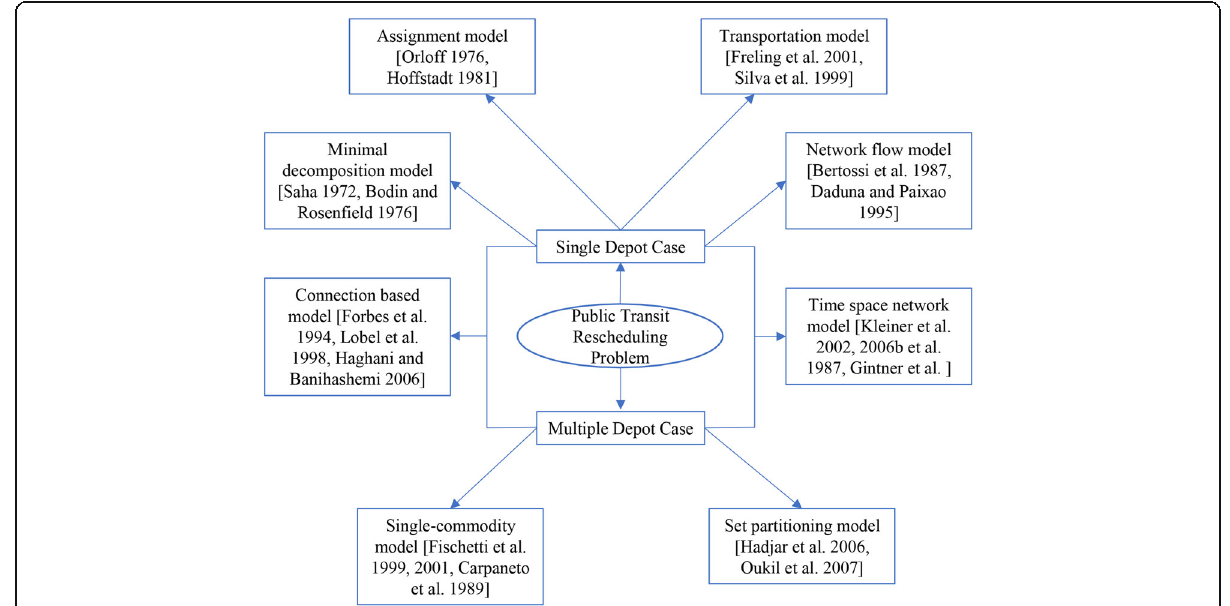
Fig. 2 Categorized reviewed articles in single and multiple depot